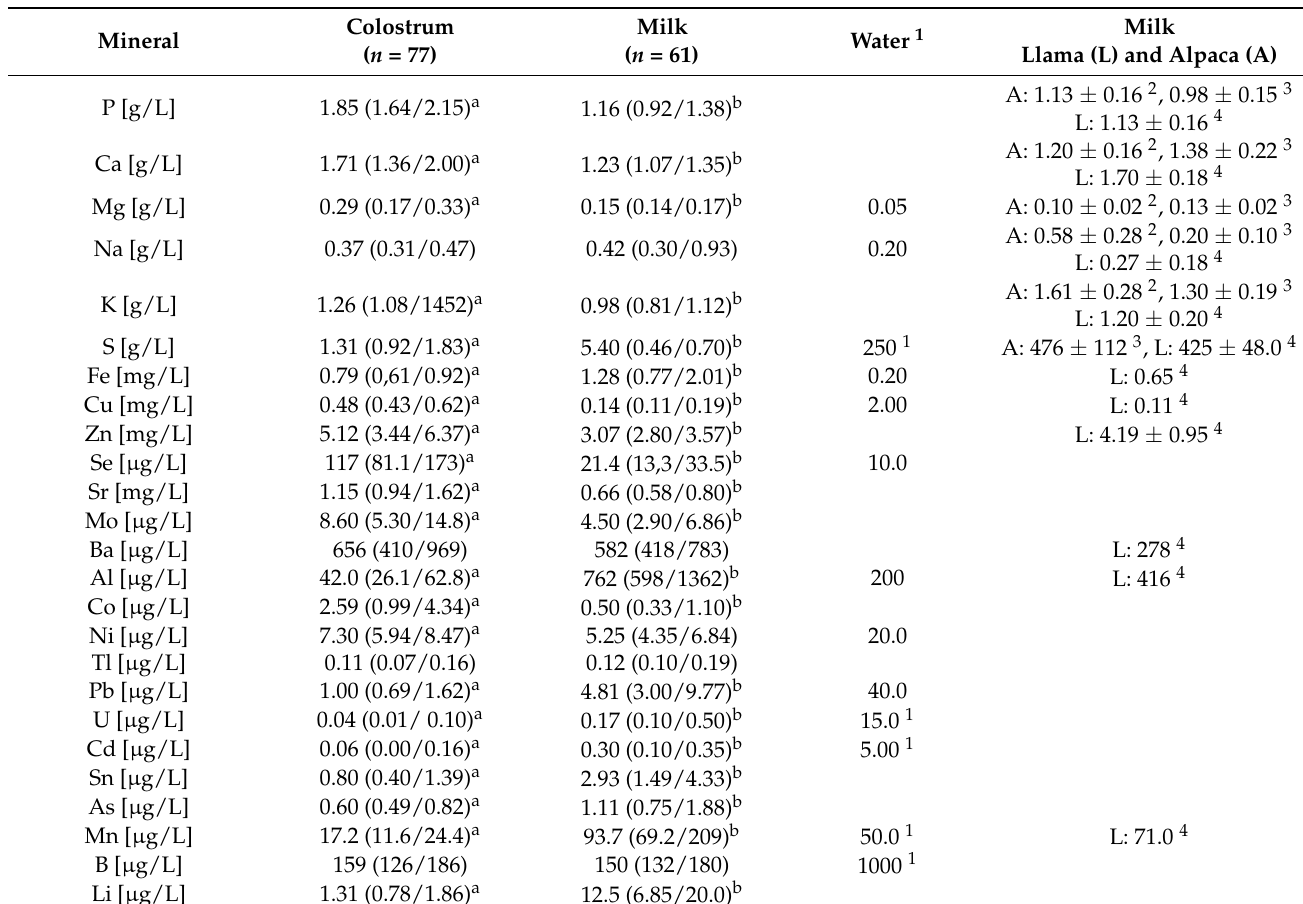
Table 6. Comparison of concentrations of macro and trace elements in alpaca colostrum (samples from day 1 to day 4 postpartum) and milk (samples from day 11 to day 120 in lactation), data provided as median (1st quartile/3rd quartile), significant differences between the days are marked with different indices. For comparison upper concentration limits for drinking water (Austria) and concentration for llama and alpaca milk reported in the literature are